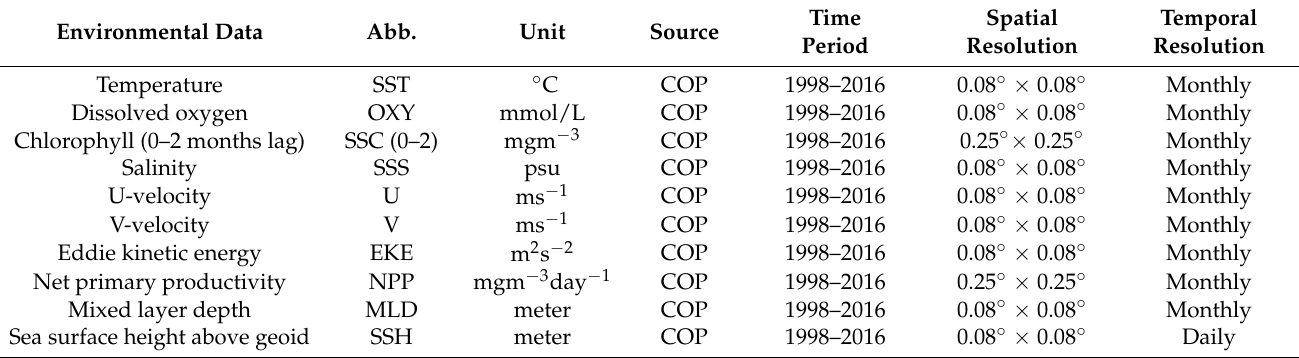
Table 1. Sources of various oceanographic variables derived from satellite